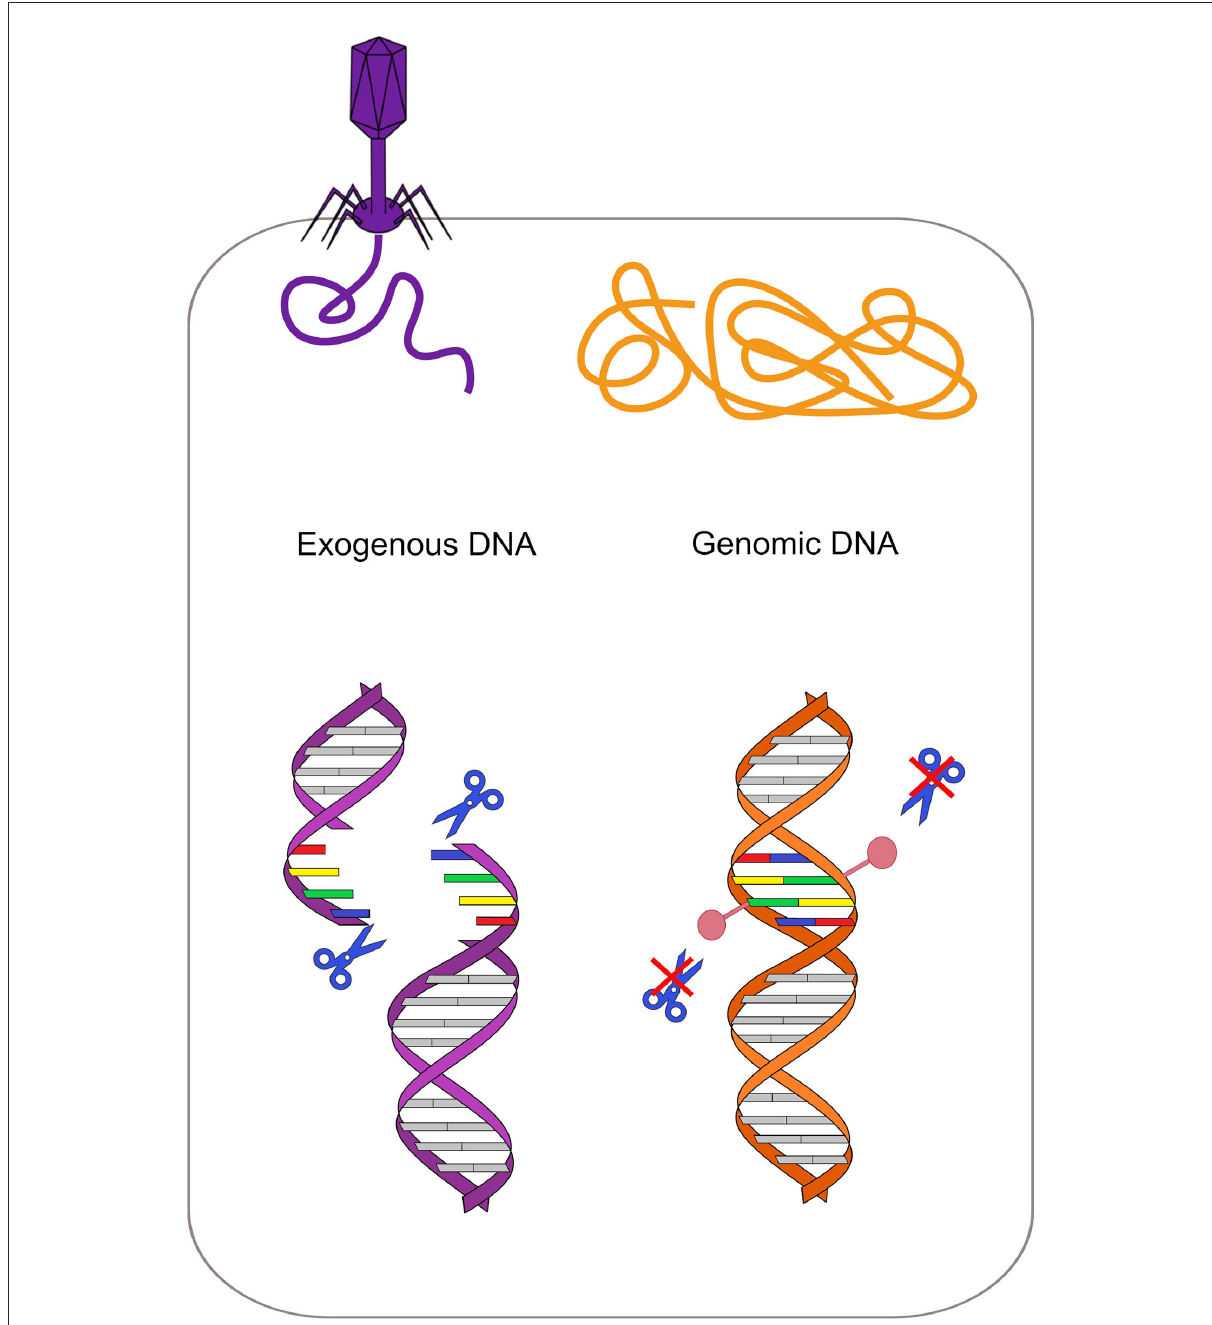
FIGURE2 Restriction-modification system protects from exogenous DNA. Each restriction enzyme recognizes a specific motif and cleaves it if it is not methylated. In the bacterial genome (orange on the right), this specific motif is methylated by the cognate methyltransferase, while the same motif is unmethylated in the phage DNA (violet on the left). Restriction enzymes can thus cleave the phage DNA only, protecting the bacterium.